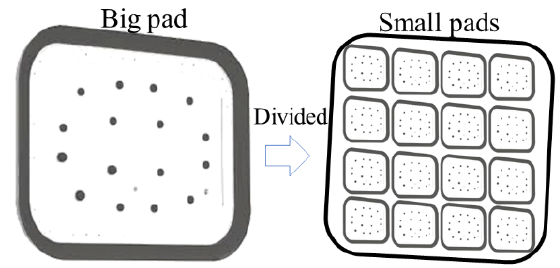
Figure 11. Pads with some small pads.